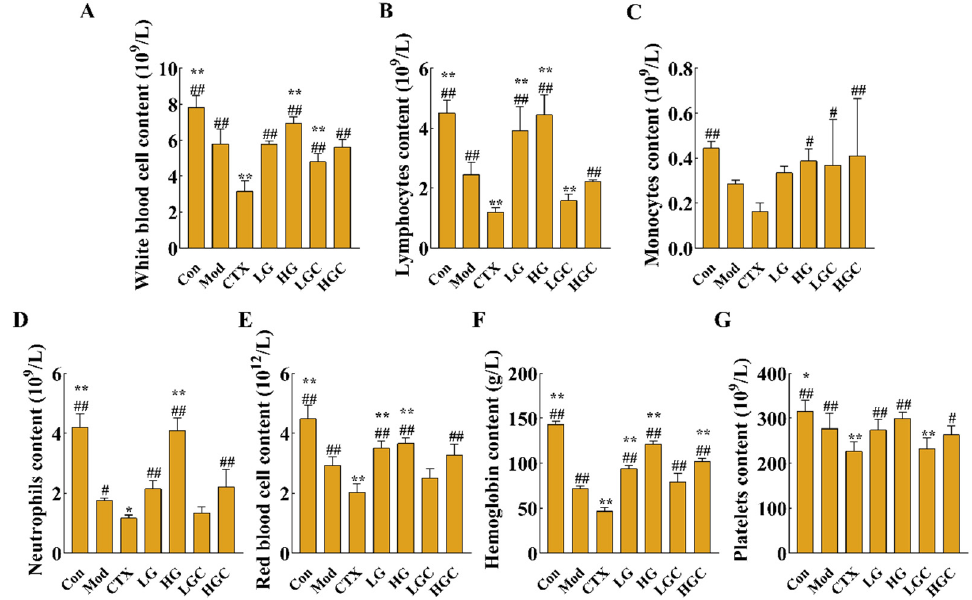
Figure 3. The blood routine examination in each group of mice. ( A ) The concentration of white blood cells in different groups. ( B ) The concentration of lymphocytes in different groups. ( C ) The concentration of monocytes in different groups. ( D ) The concentration of neutrophils in different groups. ( E ) The concentration of red blood cells in different groups. ( F ) The concentration of hemoglobin in different groups. ( G ) The concentration of platelets in different groups. Data were expressed as the mean ± SD ( n = 8). * p < 0.05 and ** p < 0.01 versus the Mod group; # p < 0.05 and ## p < 0.01 versus the CTX